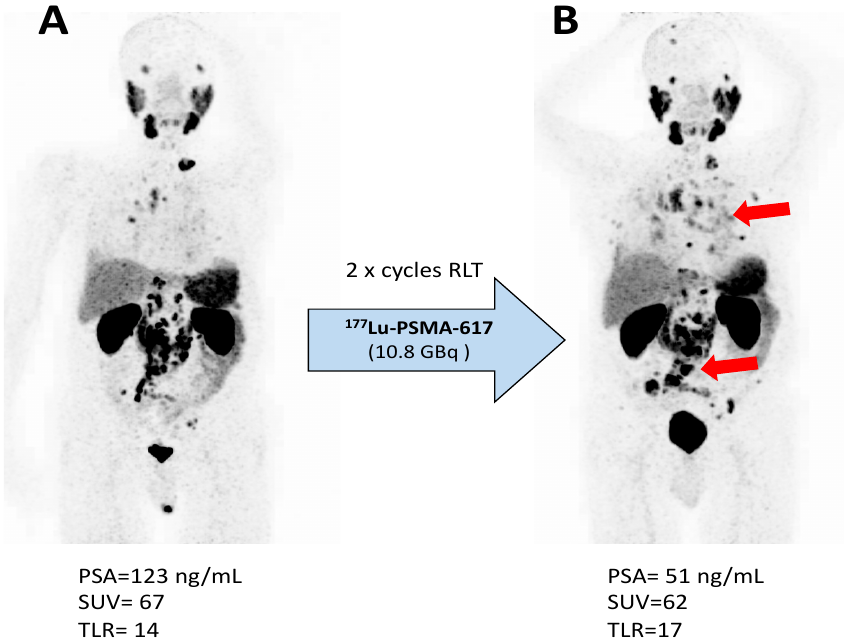
Figure 2. Progression with appearance of new metastases illustrated by 68 Ga-PSMA-11 PET/CT maximum-intensity projection images ( A ) before and ( B ) 5 weeks after the second cycle of 177 Lu-PSMA-617 RLT in a man with mCRPC. According to biochemical response based on serum PSA levels, the patient showed a partial remission.